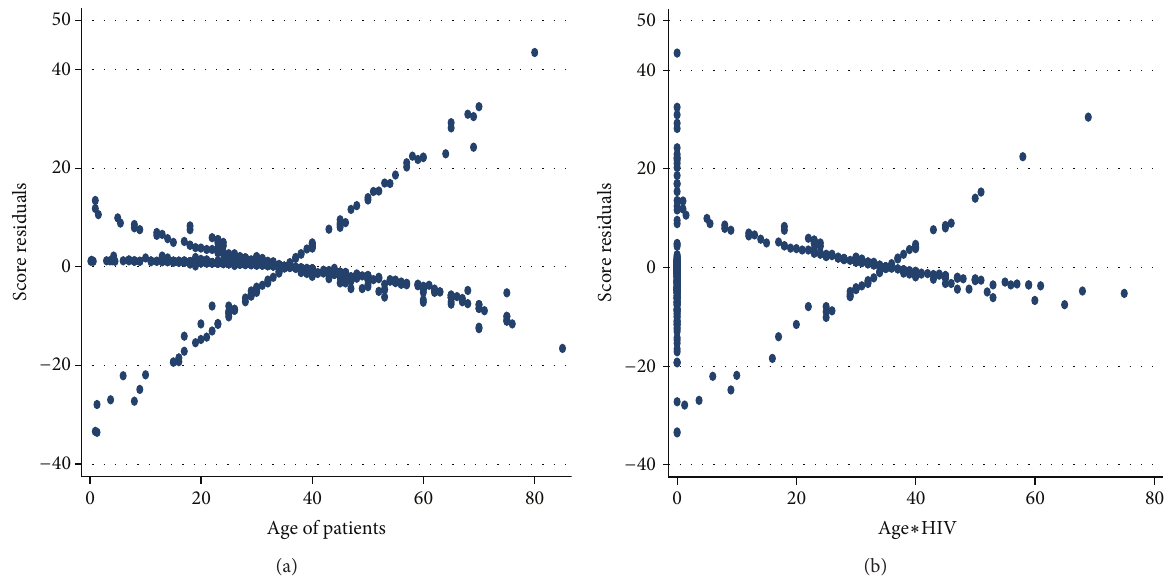
Figure 4: Graphs of the score residuals computed from the model in Table 7 for (a) age of TB patients and (b) age by HIV status interaction.